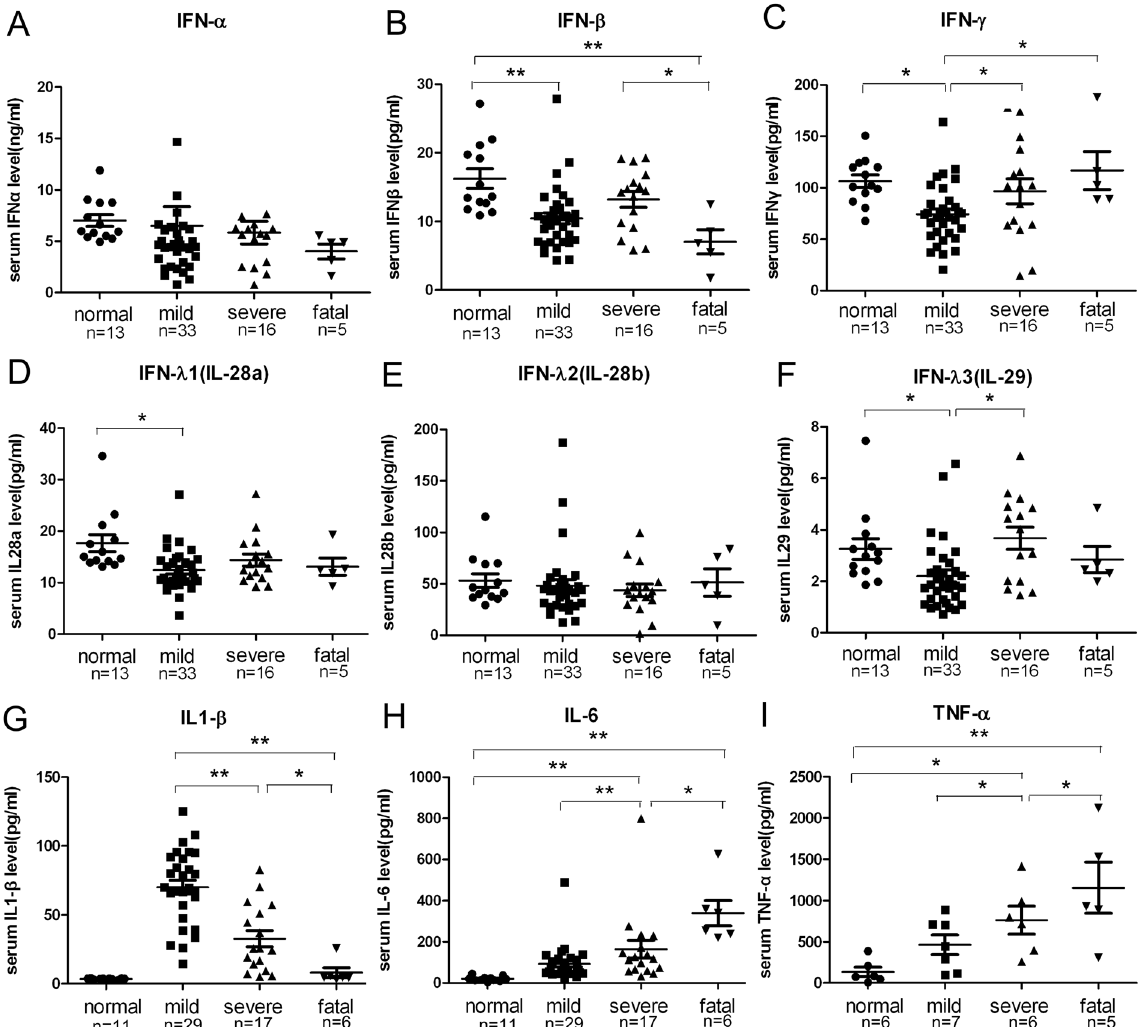
Figure 2. Comparison of type I, II and III Interferons and pro-inflammatory cytokines in the sera of SFTS patients of different clinical severities. IFN- α and IFN- β ( A,B ), IFN- γ ( C ), and IFN λ 1-IFN λ 3 ( D–F ) represent type I, type II and type III interferon response, respectively. ( G–I ) indicate serum level of three major pro- inflammatory cytokines IL-1 β , IL-6, and TNF- α , respectively. All serum samples were collected from the patients on the second day of hospitalization. * p < 0.05, ** p <